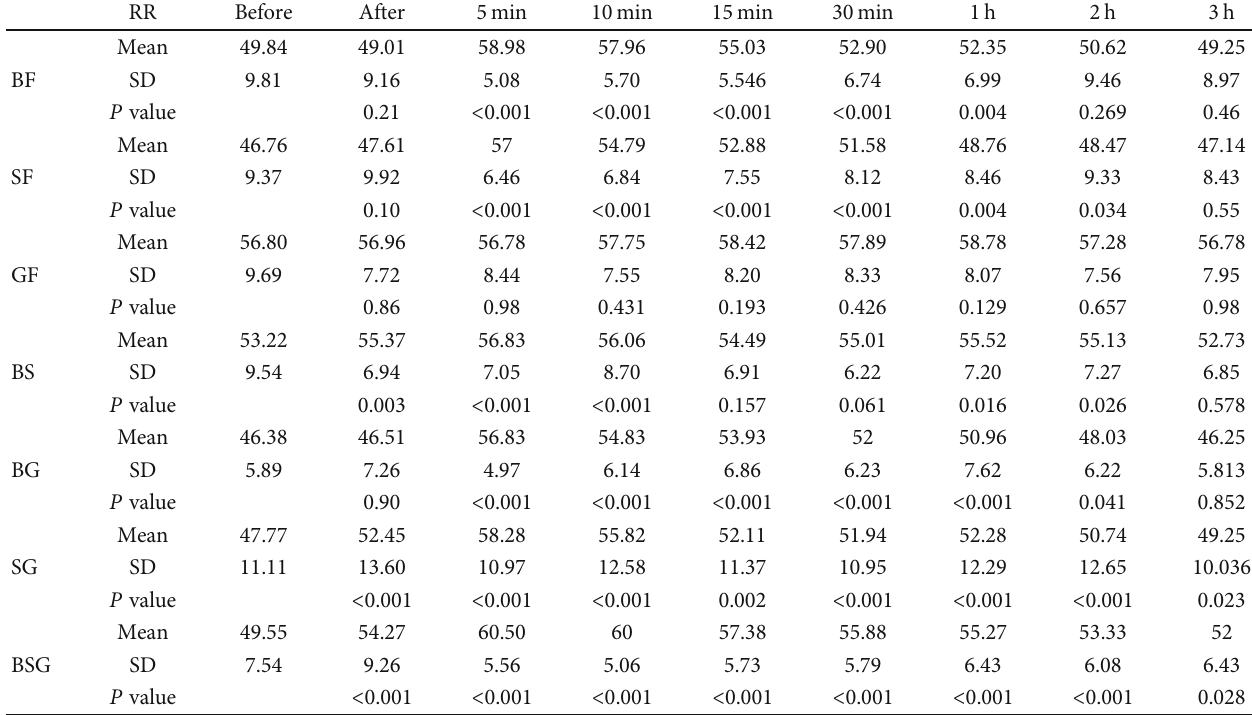
Table 2: RR at di ff erent time points for all the feeding methods.